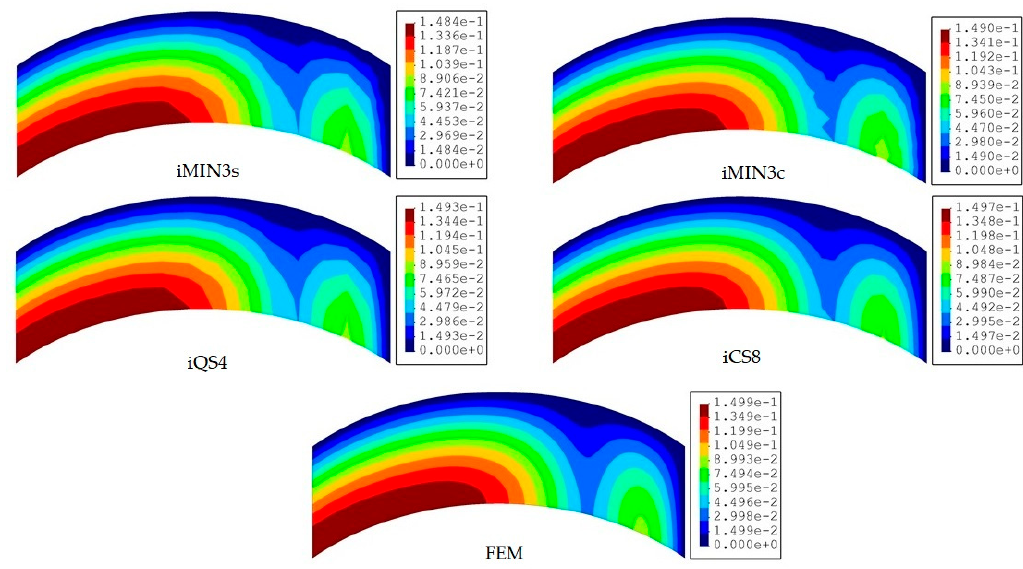
Figure 10. Contours of total displacement [mm] obtained from iFEM (fine mesh) and high-fidelity FEM analyses for the curved plate.